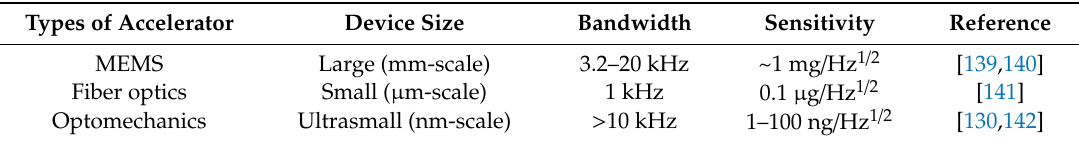
Table 4. A comparison of sensitivity versus bandwidth of three representative accelerators.